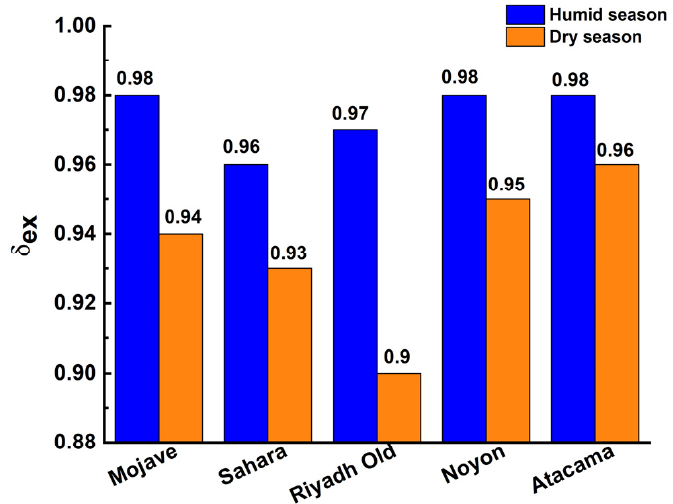
Figure 10. Water-extraction fraction δ ex for the AWHA system based on MIL-160.